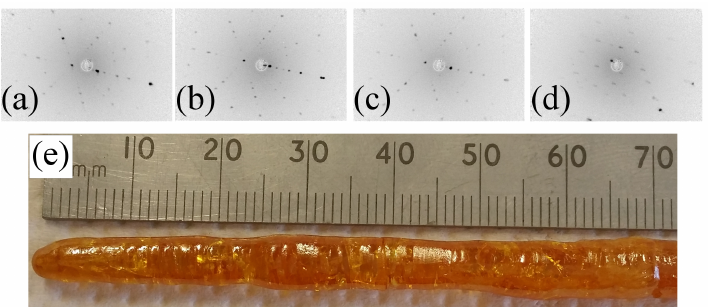
Figure 11. ( a – d ) X-ray Laue back reflection photographs of a facet of a Sm 2 Zr 2 O 7 crystal, taken along the crystal length at „ 12 mm intervals, between the end (left) and the beginning (right) of the boule. The corresponding Laue patterns taken on the facet at 180 degrees are mirror images of these patterns; ( e ) Boule of Sm 2 Zr 2 O 7 prepared in oxygen, at 4 bars pressure and using a growth rate of 8